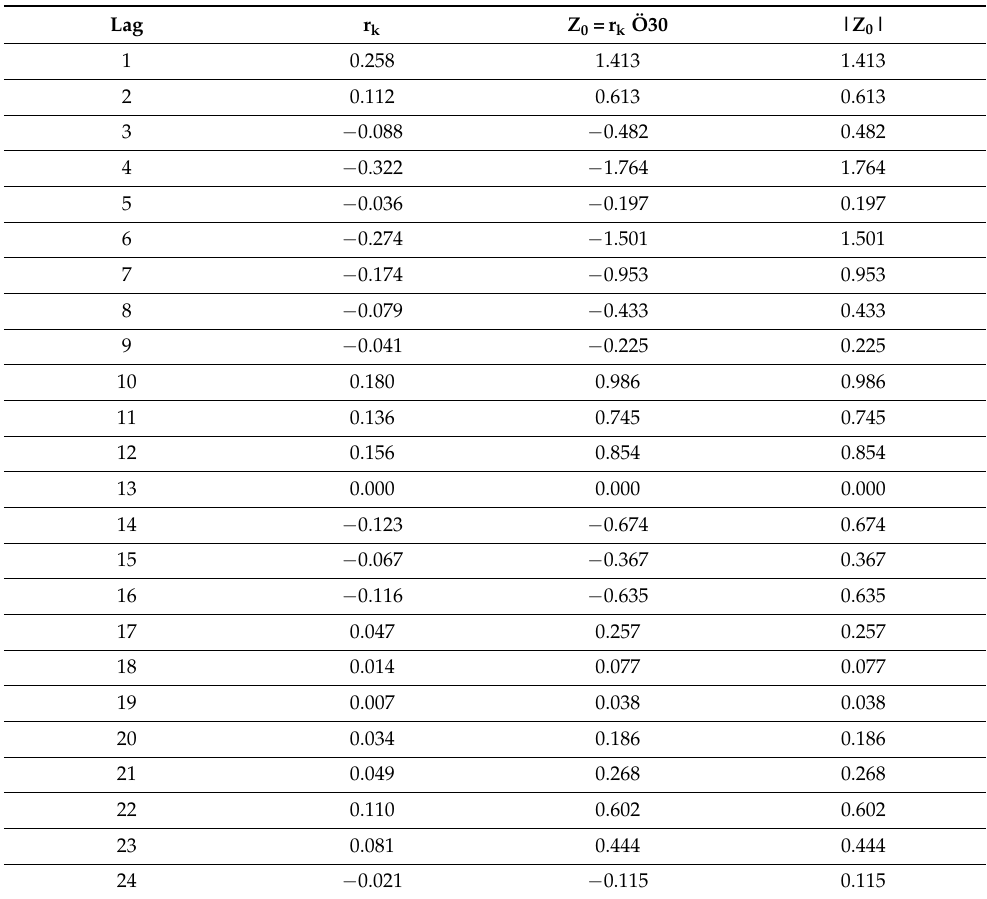
Table A8. Second order polynomial